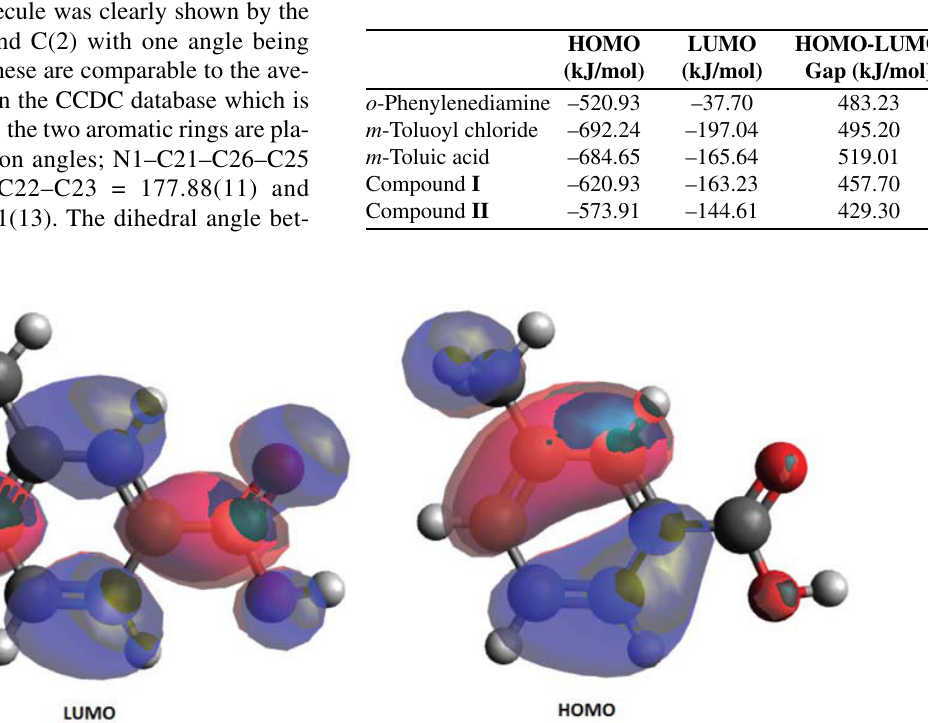
Table 3: Summary of the HOMO-LUMO energies for o -phenyle- nediamine, m -toluolyl chloride, m -toluic acid, and compounds I and II .